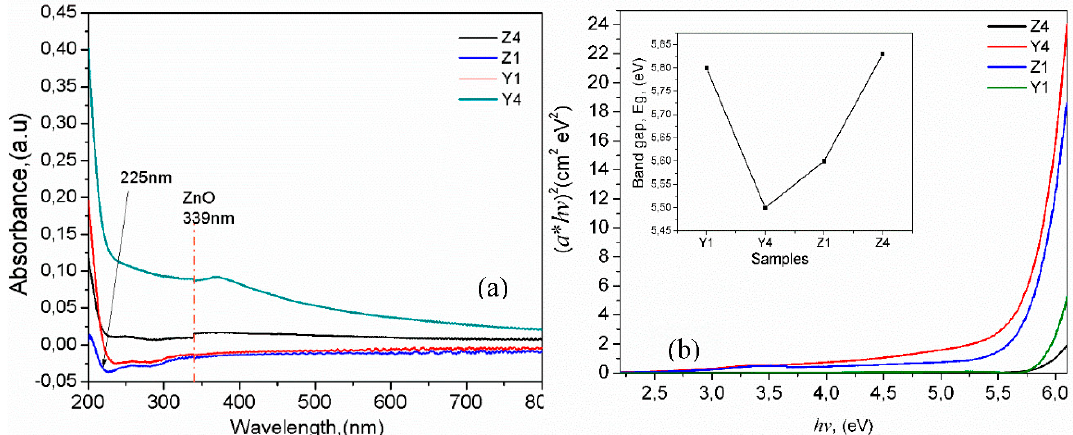
Figure 5. ( a ) Absorbance spectra of PVA-ZnO Nps; ( b ) Tauc’s plot for determination Eg , the inset shows the band gap obtained for the samples.